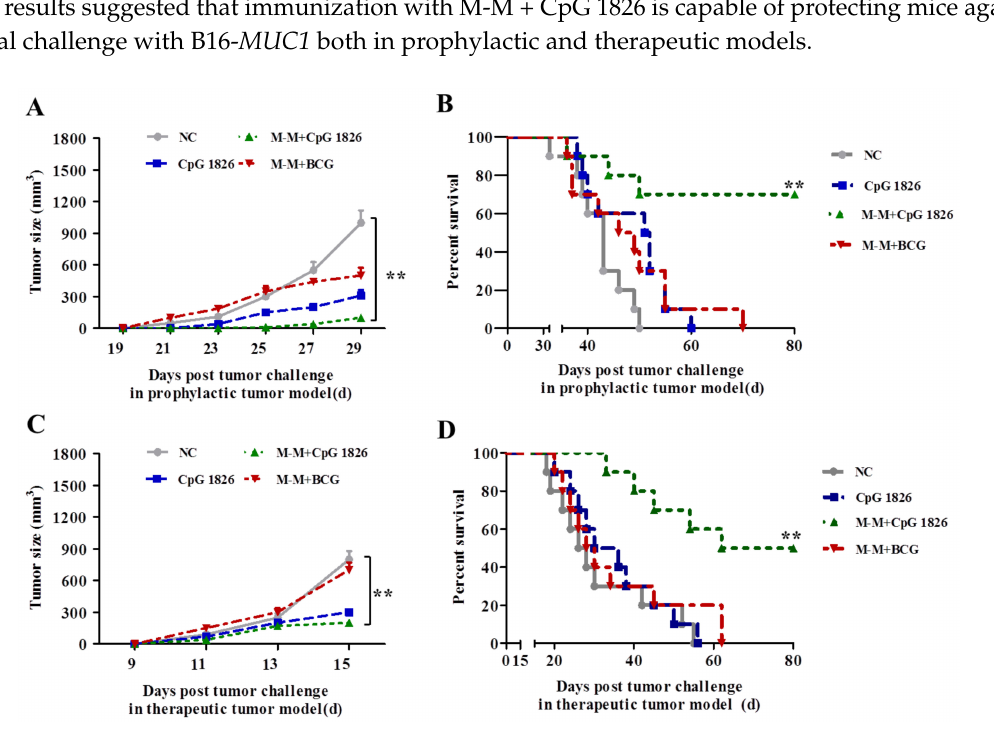
Figure 5. Role of M-M + CpG 1826 in prophylactic and therapeutic tumor models. ( A – B ) M-M + CpG 1826 vaccine induced a protective effect in a prophylactic tumor model. Four groups of mice ( n = 10) were injected s.c. with PBS, CpG 1826, M-M + CpG 1826, or M-M + BCG on day –21 and –7 and were then inoculated s.c. with 5 × 10 5 B16- MUC1 melanoma cells on day 0. Tumor volume was measured every two days, and the survival of the mice was calculated. The PBS-injected mice were used as a negative control. ** p < 0.01 vs. NC group. ( A ) The mean tumor growth curves given by the tumor volume. Each line represents the mean tumor growth kinetics of ten mice in each group. ( B ) Survival time of the mice. ( C , D ) The M-M + CpG 1826 vaccine confers therapeutic protection against melanoma. Four groups of mice ( n = 10) were inoculated with 5 × 10 5 B16- MUC1 melanoma cells on day 0 and were then injected s.c. with PBS, CpG 1826, M-M + CpG 1826 or M-M + BCG on days 7 and 21. ( C ) The mean tumor growth curves given by tumor volume. ( D ) Survival time of the